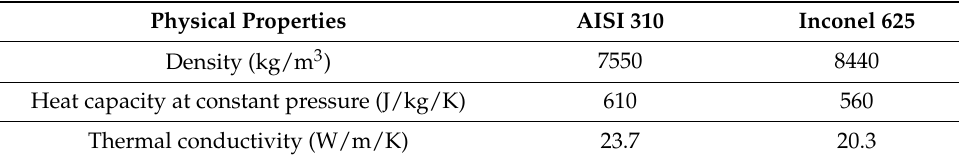
Table 4. Physical parameters for the materials.